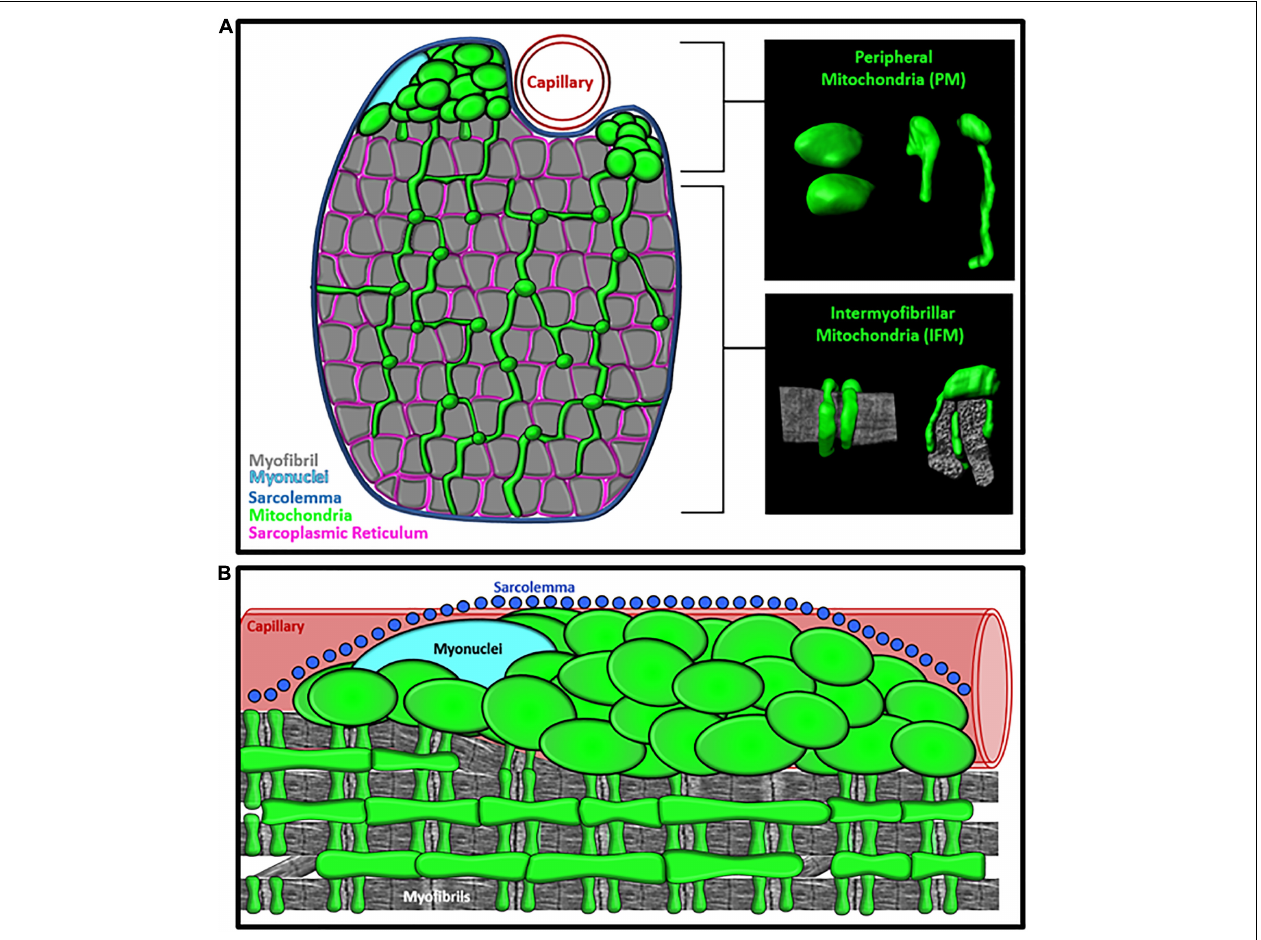
FIGURE 1 | Specialization of Mitochondrial Morphology in Skeletal Muscle. (A) Cross-section diagram of muscle cell showing the morphologically distinct peripherally-located mitochondria (PM) and intermyofibrillar mitochondria (IFM) subpopulations. Inserts provide examples of 3D morphology of PM and IFM. Mitochondria (green) and Myofibrils (gray). (B) Longitudinal view of muscle cell showing the subcellular location of PM and IFM relative to the sarcolemma (blue), capillary (red), Myonuclei (cyan), and myofibrils